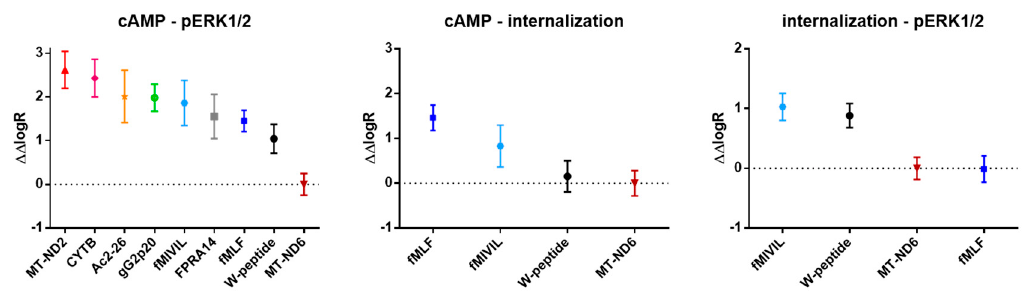
Figure 9. Comparison of agonist pathway preferences. ∆∆ logR values were calculated from ∆ logR values. Data points represent the mean and 95% confidence intervals.